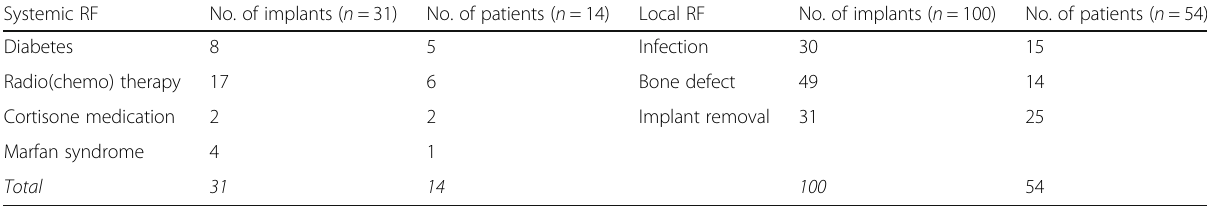
Table 1 Distribution of patients with local and systemic risk factors Systemic RF No. of implants ( n = 31) No. of patients ( n = 14) Local